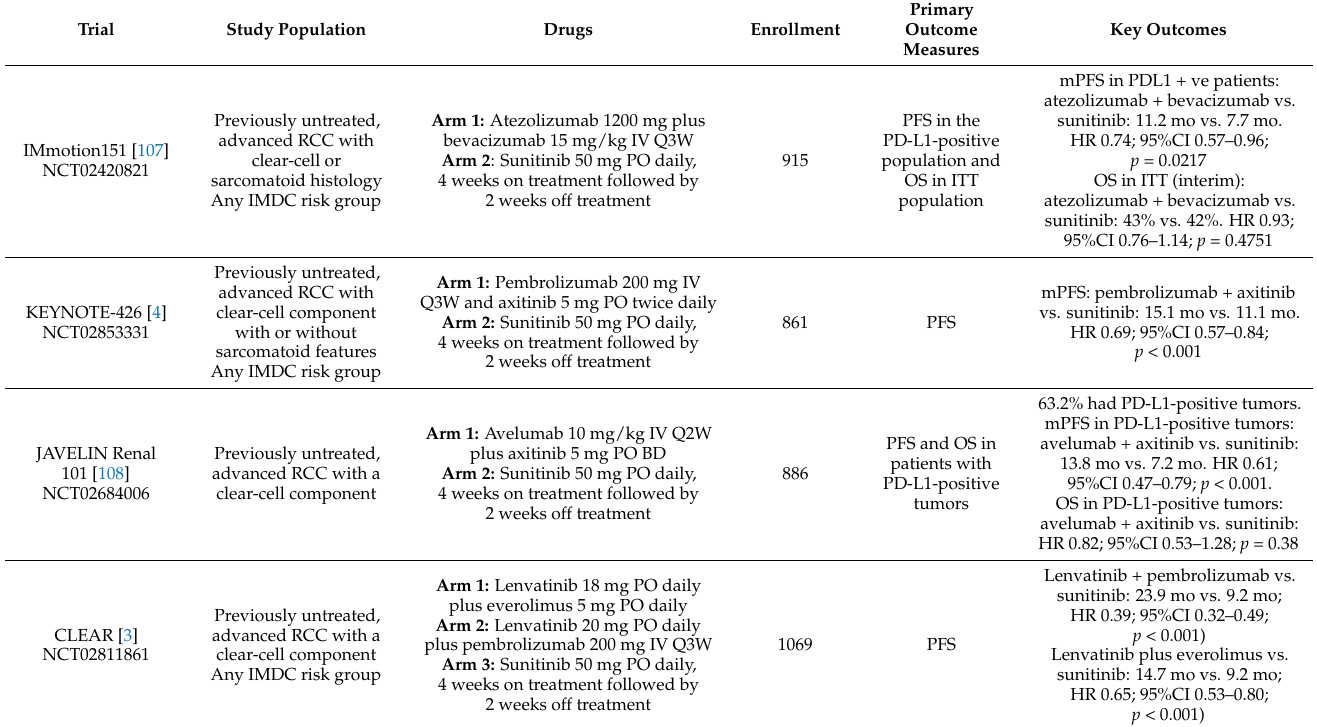
Table 1. Presented phase III studies regarding combination immune checkpoint inhibitor and anti- angiogenic therapy trials in previously untreated, advanced-stage clear-cell renal cell